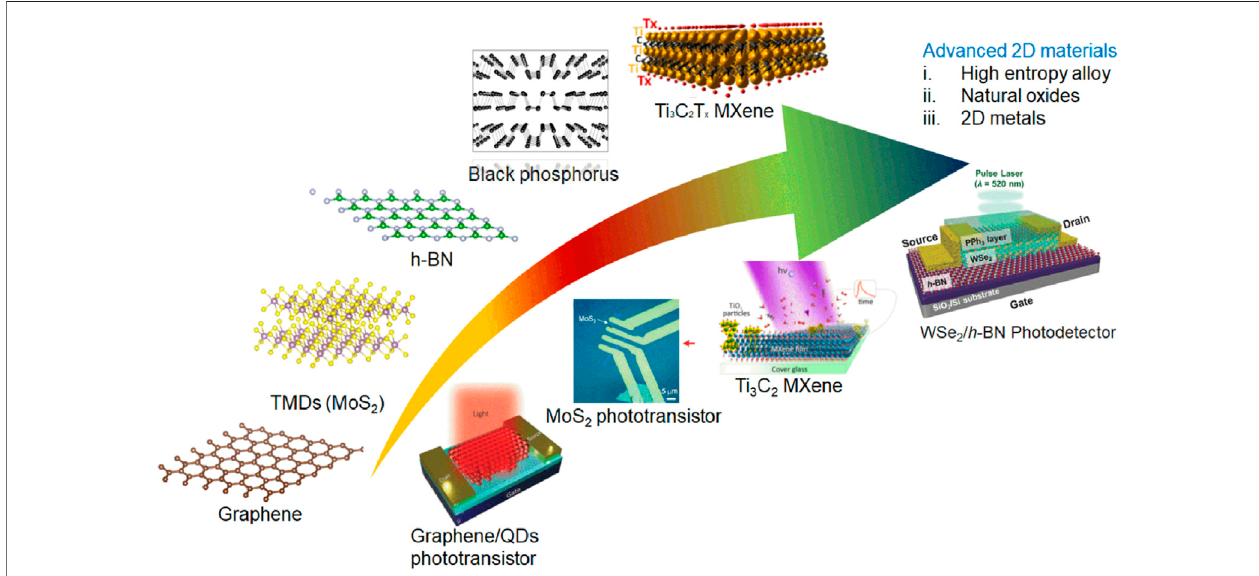
FIGURE1| Overviewofdifferenttypesof2Dmaterialsandtheiroptoelectronicapplications.[adaptedandmodi fi edfrom(Konstantatosetal.,2012;Yinetal.,2012; Jo et al., 2016; Chertopalov and Mochalin, 2018)]